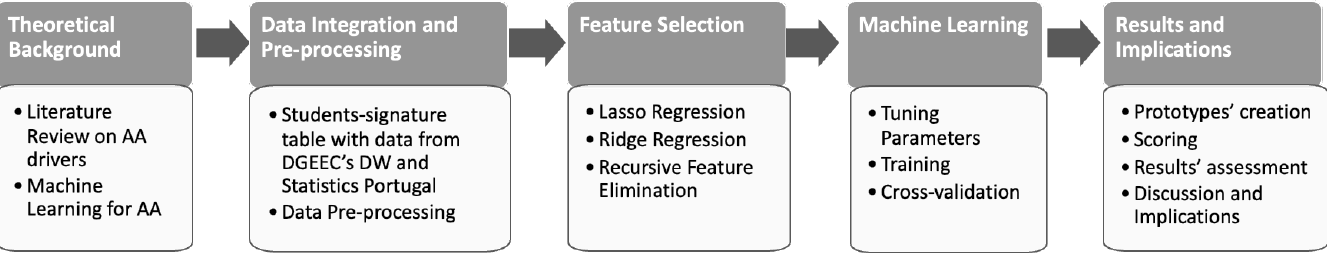
Figure 1. Predicted impacts of changing a unit in each variable, ceteris paribus, using